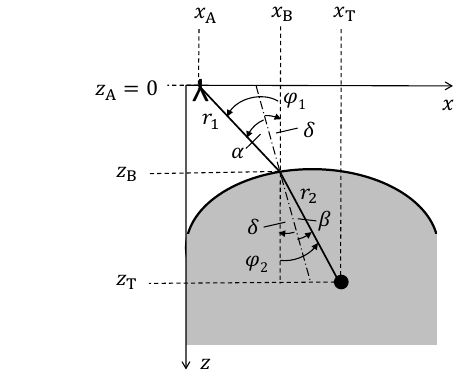
Figure 1. Model and